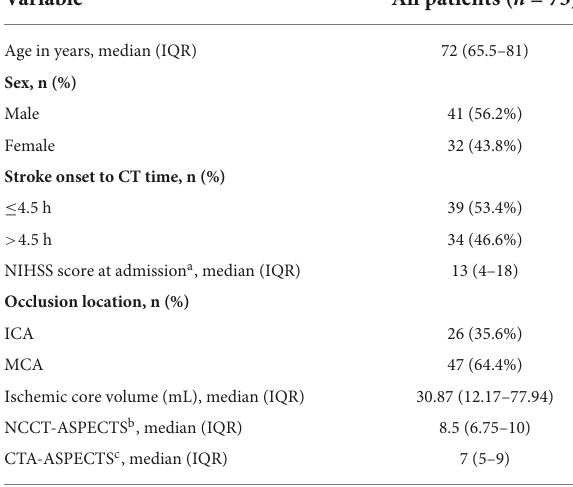
TABLE 1 Demographic and clinical characteristics of